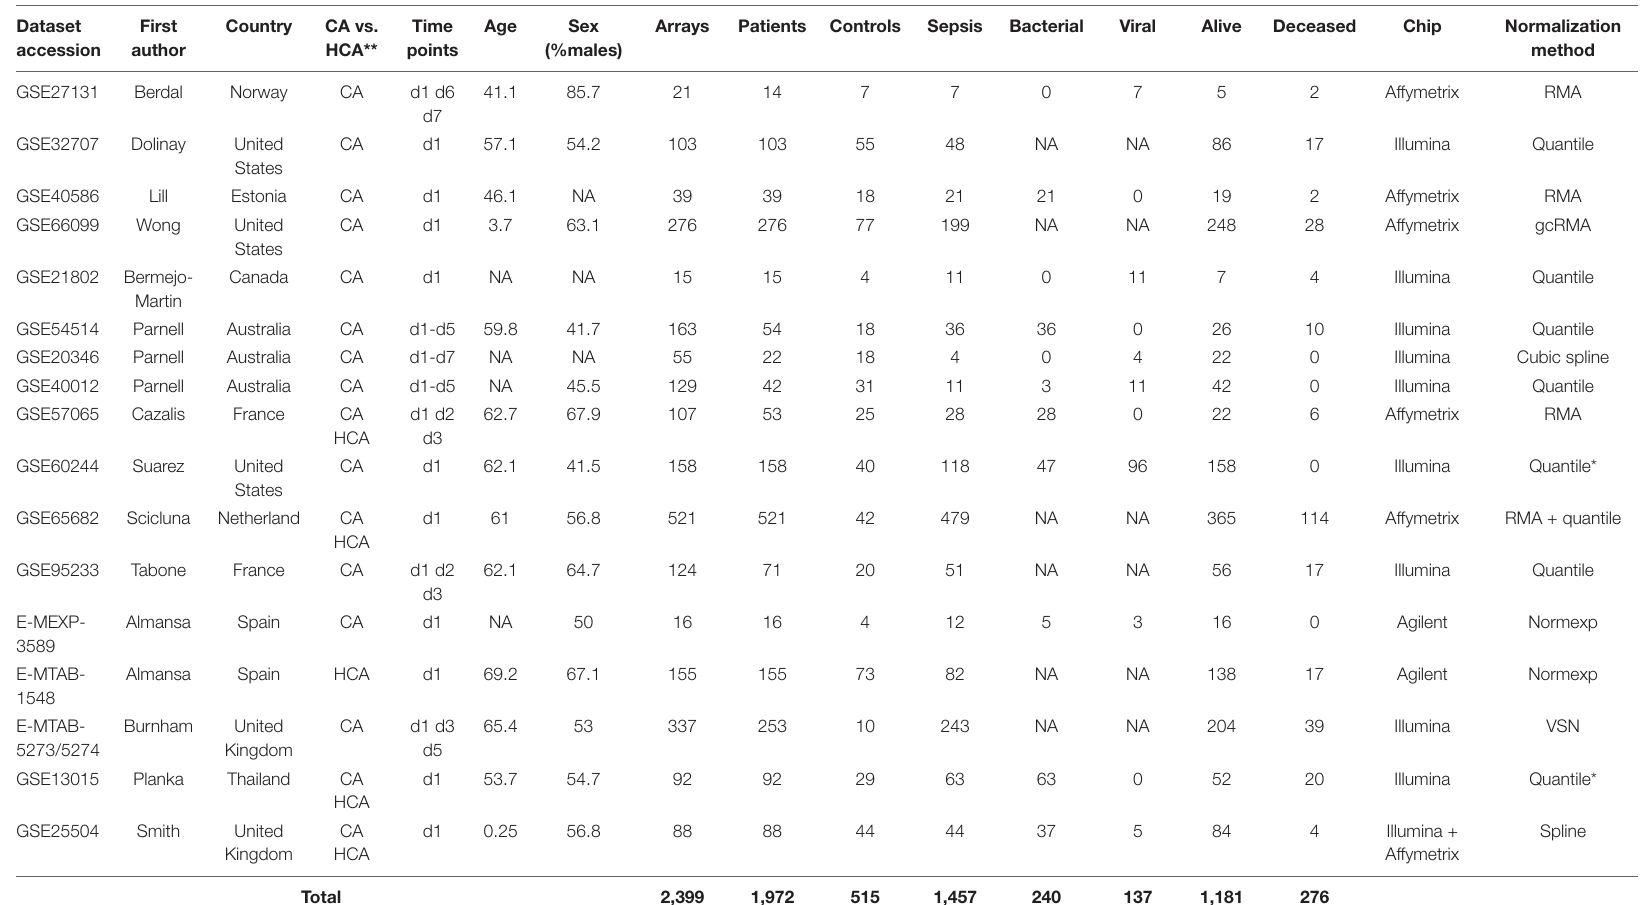
TABLE 1 | Characteristics of the cohorts, patients and microarray data included in the study. Dataset